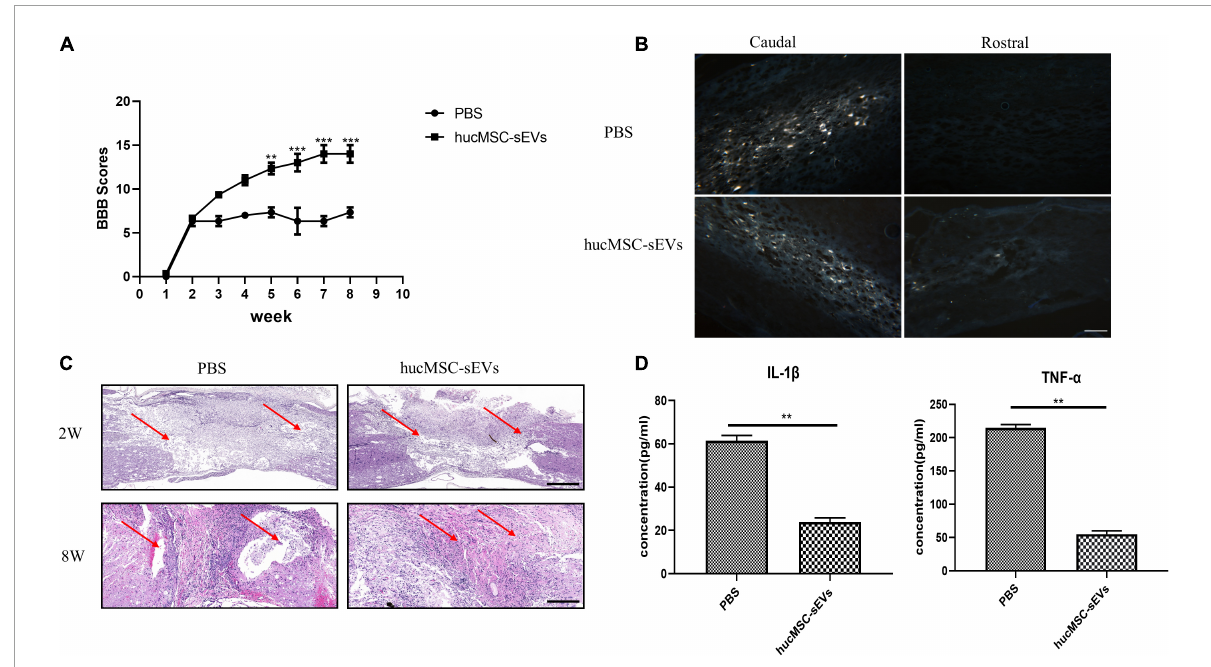
FIGURE2 hucMSC-sEVs promoted the functional recovery and attenuated inflammation after SCI. (A) BBB scores for rats in the PBS and hucMSC-sEVs treated groups. (B) Representative fluorescent-gold retrograde staining of transverse spinal cord sections 8 weeks post-injury. Scale bars, 100 µ m. (C) H&E staining of spinal cord at 2 and 8 weeks post-surgery. Scale bars, 200 µ m. (D) Expression levels of inflammatory cytokines (IL-1 β and TNF- α ) in different groups. The data are presented as means ± SD; n = 3; ** p < 0.01, *** p < 0.001 vs. PBS group.